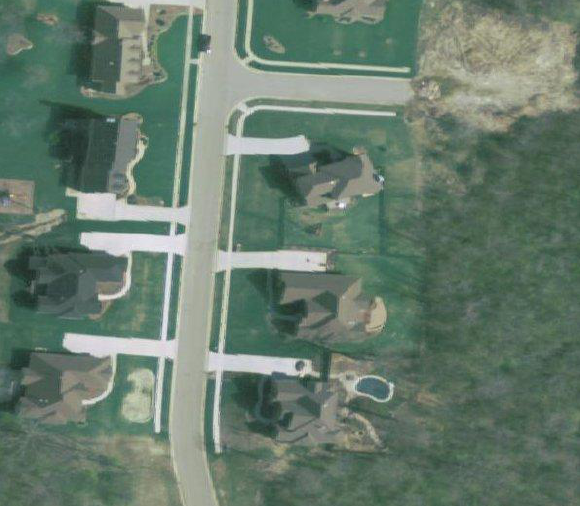
Figure 1: Test area, Dayton,